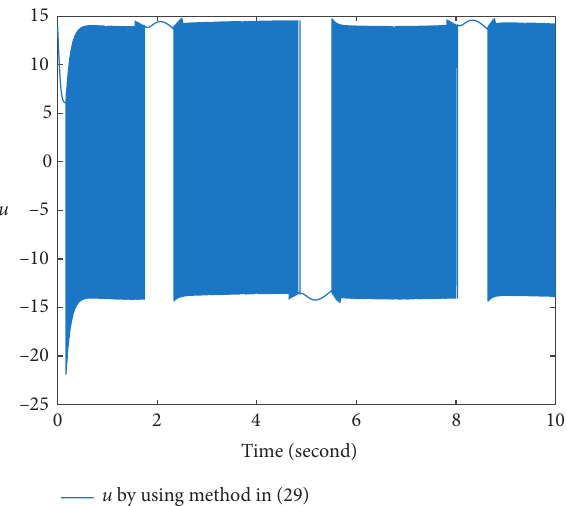
􏽢 ( x ) + d ( t ) by using F